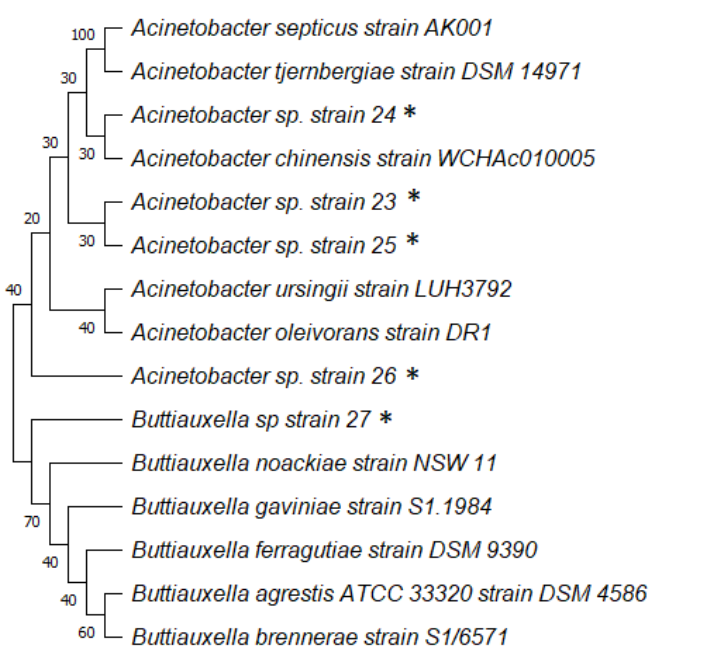
Figure 3. Phylogenetic analysis of auxin-producing microorganisms using 16S rDNA gene sequencing technique. Microorganisms followed by an asterisk * correspond to the five strains with the highest auxin production, which were used in the inoculation. 3.4. Evaluation of In Vitro Inoculation: In Vitro Development and Acclimatization Considering the results obtained for the rootstock ‘OHxF87 ′ , there were differences in the percentage of survival with and without inoculation of microorganisms. The sur- vival of plants with in vitro inoculation of A. septicus strain 23 and A. ursingii strains 24, 25, and 26 was higher than the rate observed in the treatment with synthetic auxin. The bacterial strains 23 and 25 resulted in 80% in vitro survival, while strains 24 and 26 showed an in vitro survival rate of around 70%. For synthetic auxin, the in vitro survival rate was 35% (Figure 4).